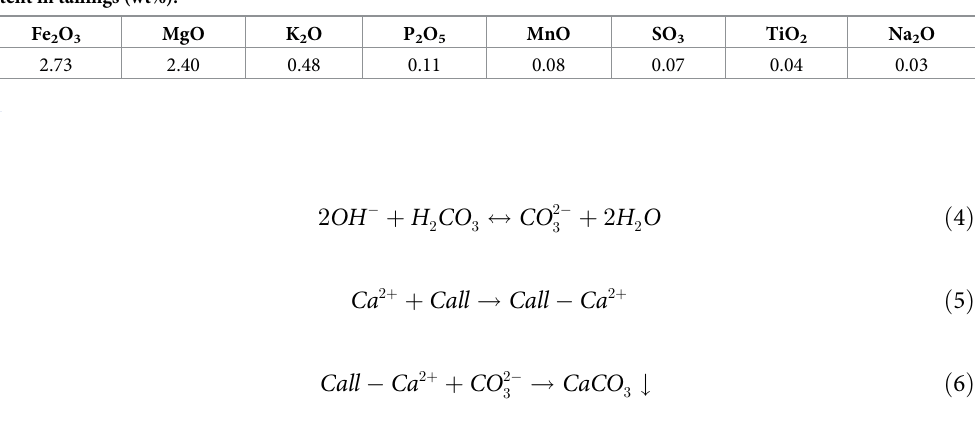
To sum up, a tailings cementation method by mixed facultative anaerobes ( Castellaniella denitrificans or C . denitrificans ) and Sporosarcina pasteurii ( S . pasteurii ) is proposed in this paper. The influences of different mixing modes on the cementation effect are investigated so as to improve the cementation effect. Based on the research in this paper, it is found that in the process of soaking and curing, the cementation effect is better when facultative anaerobic bac- teria and aerobic bacteria are used to act together on the tailings.